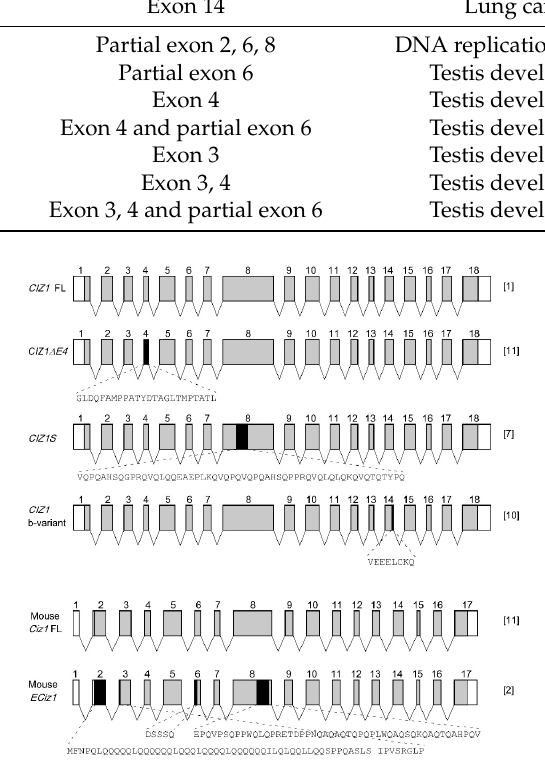
Figure 2. Selected alternative splicing patterns of CIZ1 mRNA. In this diagram, we show several splicing variants, as well as the full-length of CIZ1 mRNA of human (Accession No. NM_001257975.1) and mouse (Accession No. NM_028412.2) species. The full-length of CIZ1 mRNA of human contains 18 exons, while that of mouse contains 17 exons. The exon numbers are indicated at the top. The alternatively spliced sequences are shaded with black. The width of the oblongs represents the relative length of the exons. The omitted amino acid tracts in the protein products due to alternative splicing are also shown in the diagram. The relative references are indicated on the right of each variant.